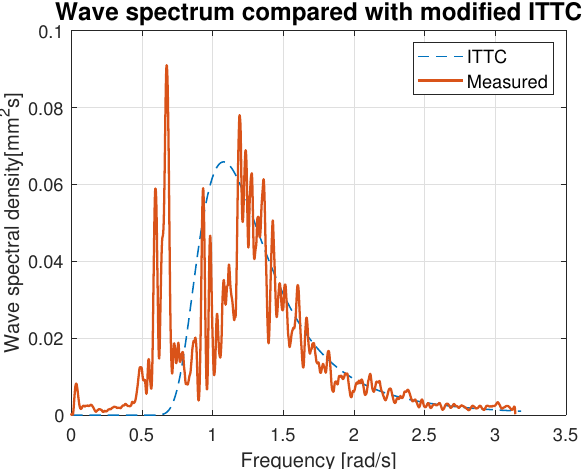
Figure 16. Comparison of the empirical wave spectrum evaluated for 4 BFT wind force in ship scale and the modified ITTC model.